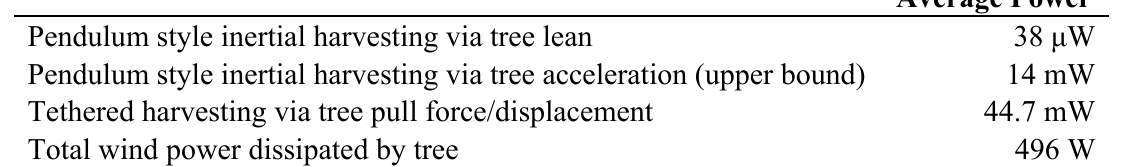
Table 3. Summary table of results, from analysis of tree movement energy harvesting